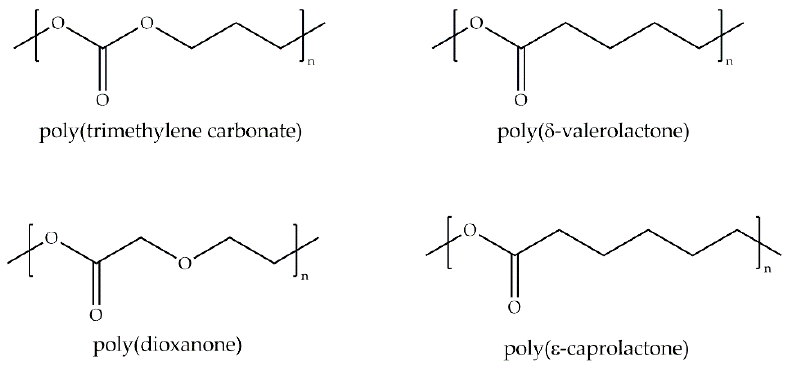
Figure 13. Molecular structure of aliphatic carbonyl polymers.